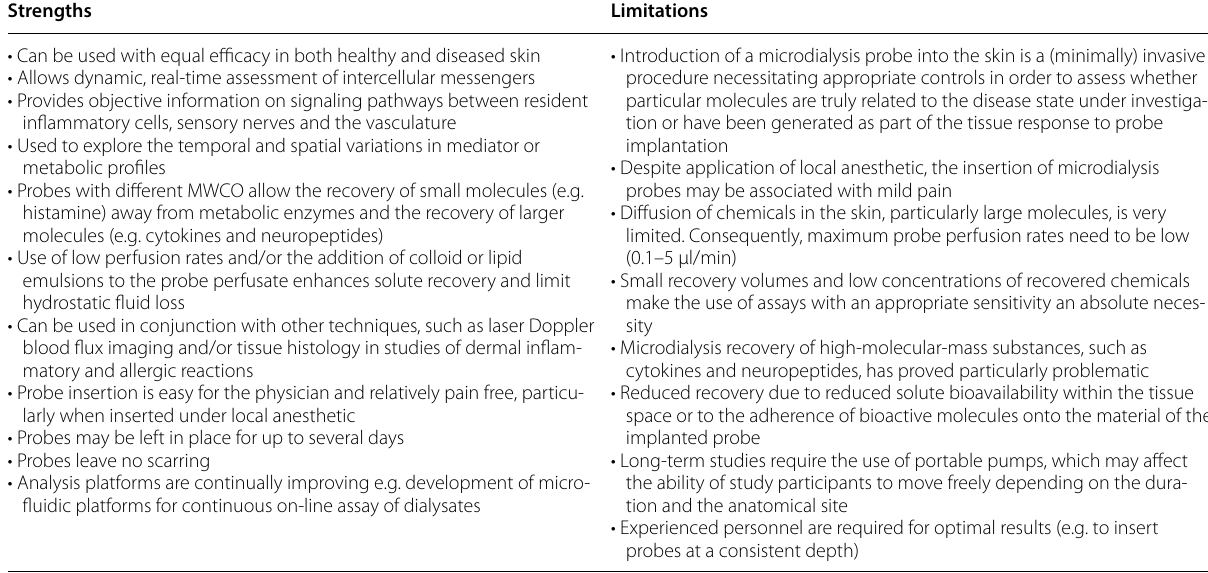
Table 2 Strengths and limitations of SMD for the study of inflammation and allergy in the skin (see text for further information and